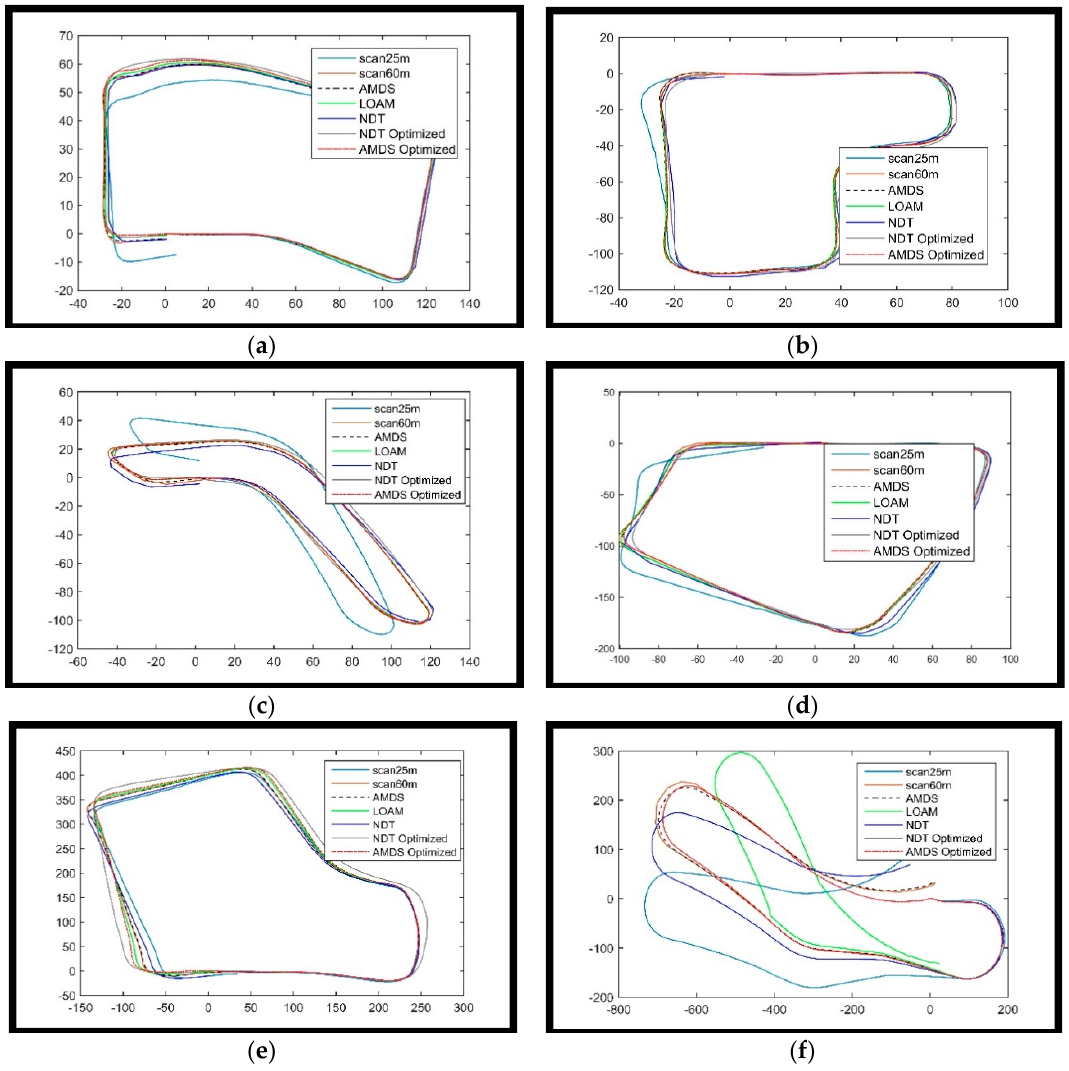
Figure 10. Trajectories generation: ( a ) Trajectory results on map 1, ( b ) trajectory results on map 2, ( c ) trajectory results on map 3, ( d ) trajectory results on map 4, ( e ) trajectory results on map 5, and ( f ) trajectory results on map 6.